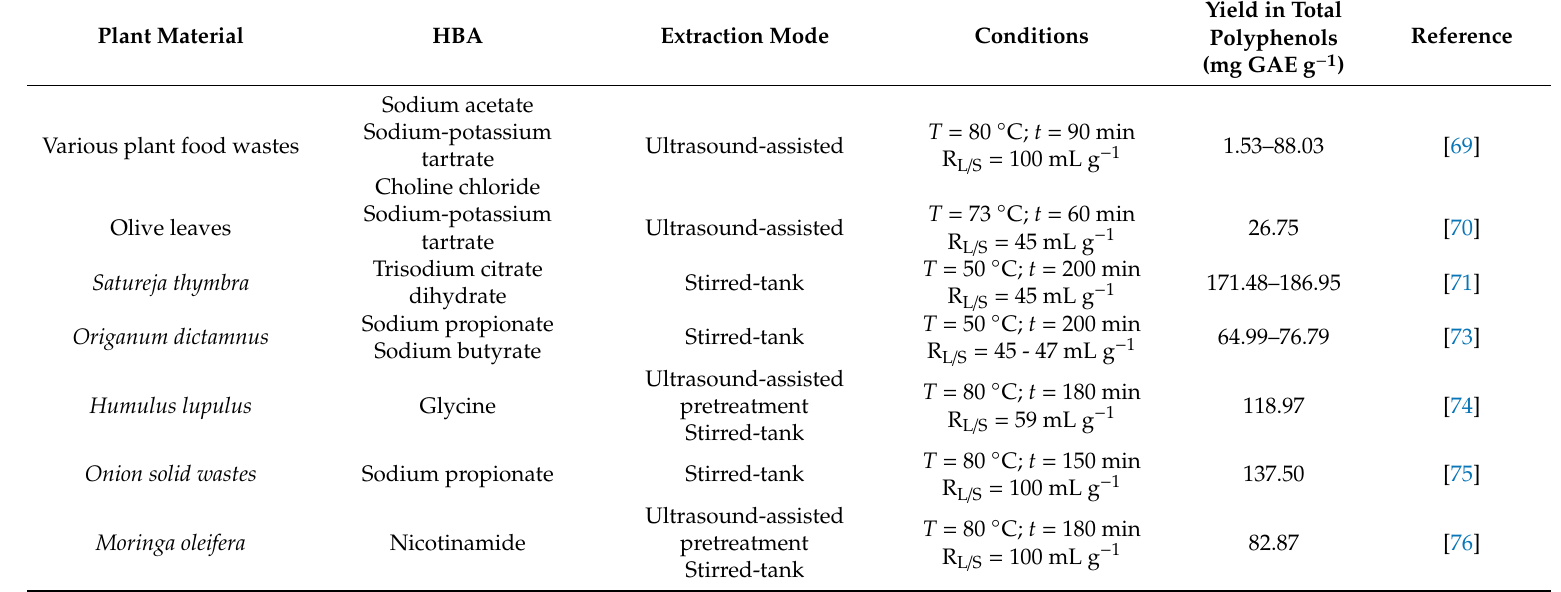
Table 3. Representative examples of total polyphenol recovery from plant materials using glycerol-based